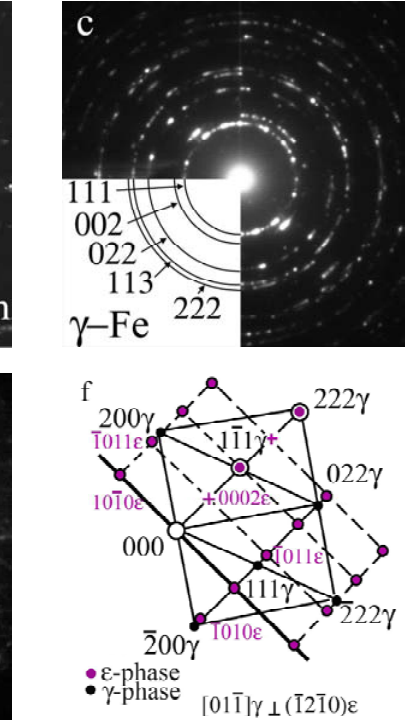
Fig. 2. TEM bright-field (a, d) and dark-field (b) images, SAED pattern (c, e) for UFG-CrNiMo steel. Recrystallized grains are marked by arrows on the image (a). Grains with plates of  -phase are circled on the images (a, d). SAED patterns (c, e) correspond to the images (a, d) and are obtained from the areas of 1.3  m 2 and 0.05  m 2 , respectively. Combined (  +  ) spot diffraction pattern on (f) corresponds to SAED pattern